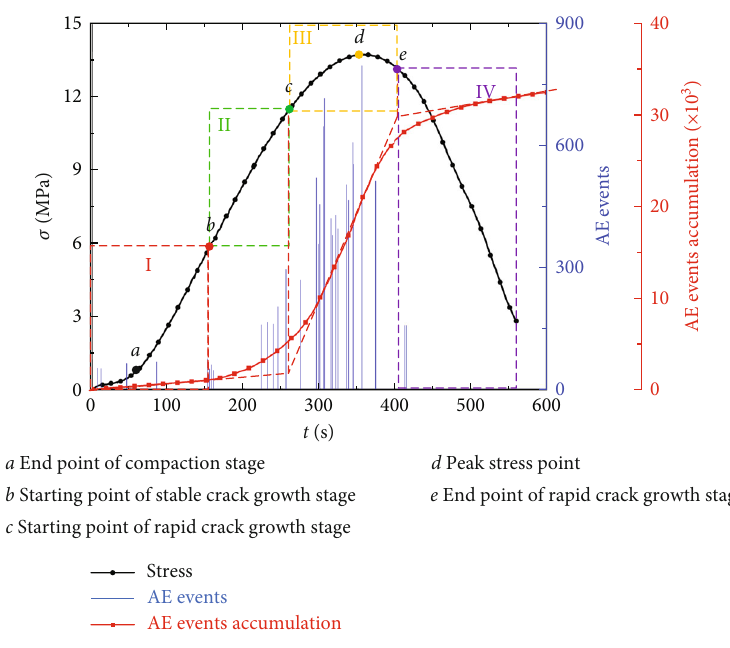
Figure 10: Comparative analysis of stress and acoustic emission signals with S = 20 % .